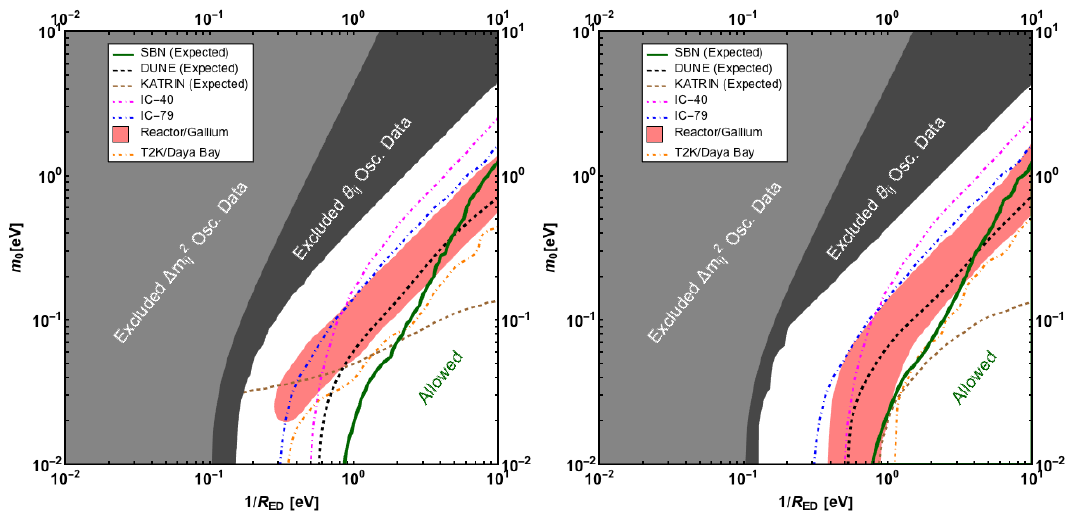
Figure 2 . Left (Right) panel: sensitivity limits for the LED parameters, R ED and m 0 , considering normal (inverted) ordering of neutrino masses. The regions for LED sensitivity, considering muon disappearance and electron appearance channels, are to the top-left of the curves. Here, we show our 90% C.L. line from SBN limit (green), the 95% C.L. lines from DUNE (black) [38], ICECUBE- 40 (magenta) and ICECUBE79 (blue) [36], and 95% C.L. from combined analysis of T2K and Daya Bay (gold) [37]. The 90% C.L. line from KATRIN sensitivity analysis is also shown (brown) [35] and the pink regions are preferred at 95% C.L. by the reactor and Gallium anomaly [34]. The light and dark gray regions are excluded due to neutrino oscillation